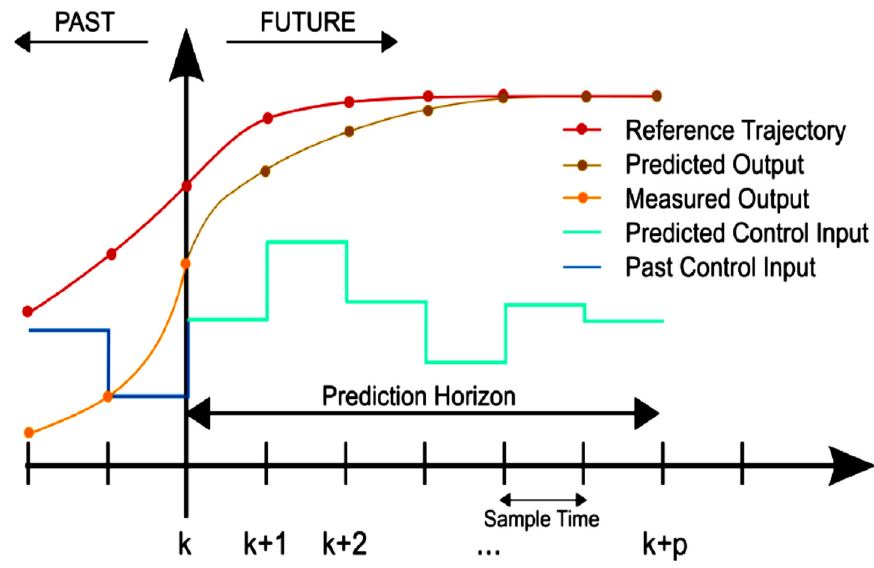
Figure 2. The MPC behavior at sampling instant t.